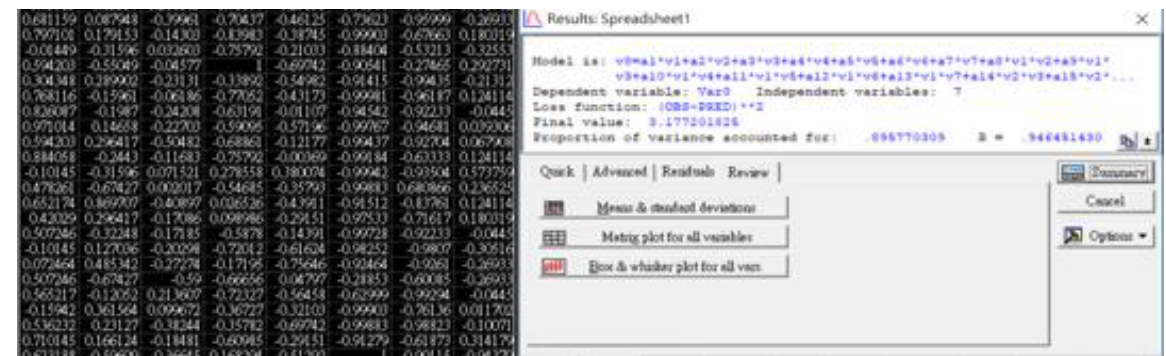
Figure 4. The calculated outcomes from STATISTICA 7.0 program. The customized loss function equals 0.0 if there is a 100% match between theoretical prediction and practical observation, whereas the derived value is 3.177 in this study. Table 3. The coefficients of the 29-term semi-empirical formula (cf. Equation (7)) from the calculated outcomes of the STATISTICA 7.0 program. The factors were all normalized from −1 to +1. Thus, the large derived coefficients significantly dominate the performance of SYNTX score prediction.